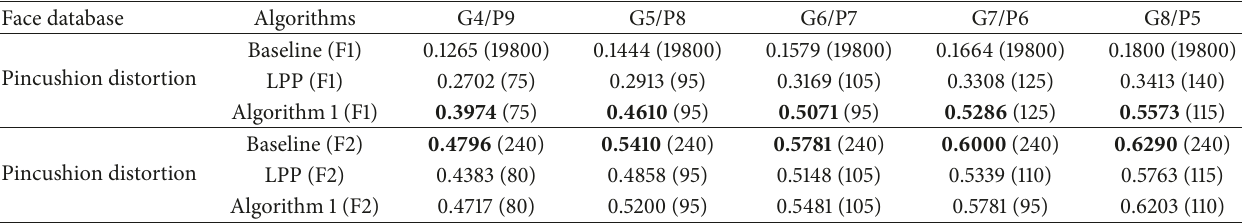
Table 7: The recognition rates on pincushion distortion AR face database over “F1” and “F2” features; recognition rates (dimensionality).